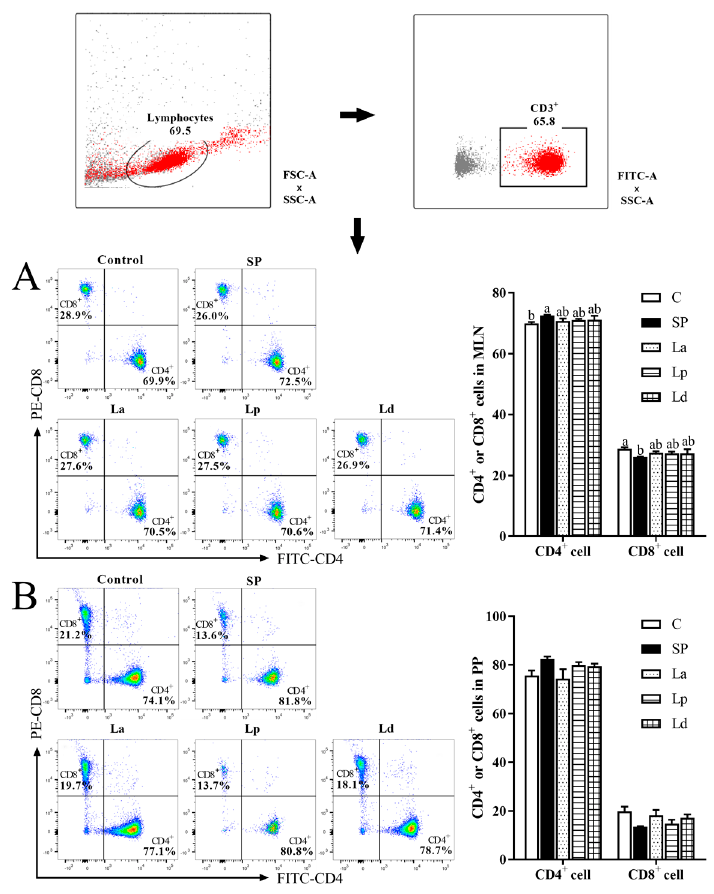
Figure 4. Effect of Lactobacillus on the percentage of Th (CD4 + ) and Tc (CD8 + ) cells in the MLNs ( A ) and PPs ( B ) of soy-allergic mice ( p < 0.05). Different letters denote statistically significant differences ( p <